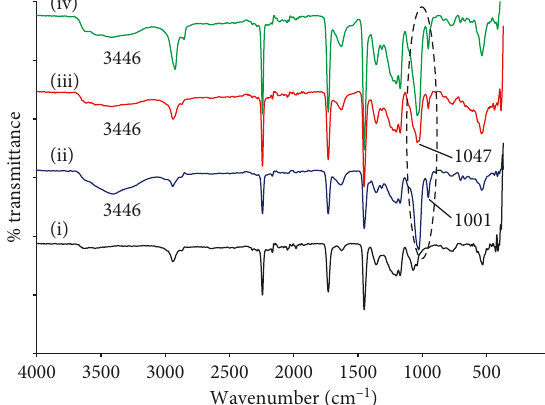
Figure 2: FTIR spectra of (i) PAN, (ii) TiO PAN, and (iv) CdS-PAN